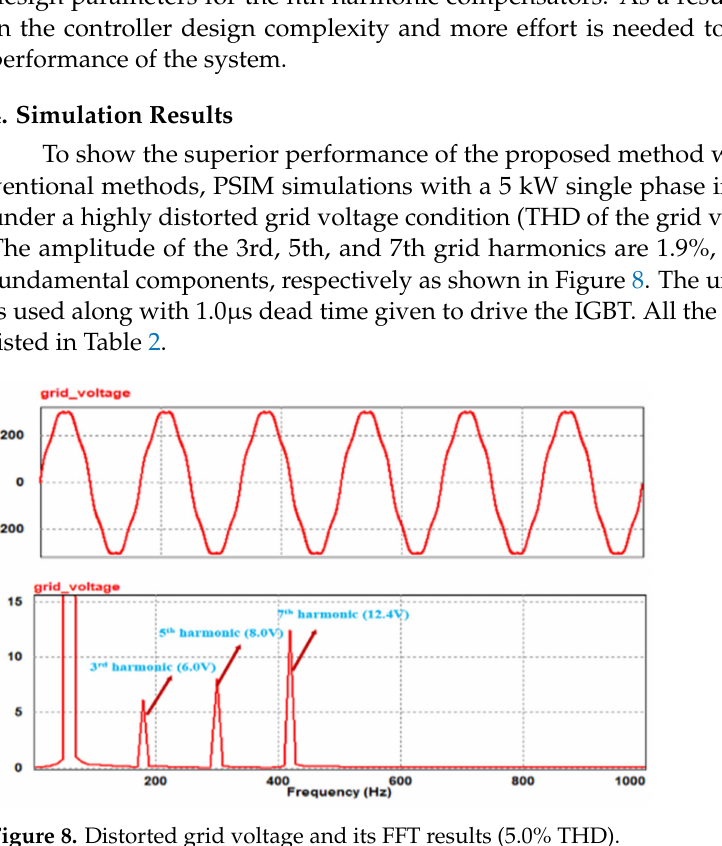
Figure 8. Distorted grid voltage and its FFT results (5.0% THD). Table 2. Parameters of the Single-Phase Grid-Connected